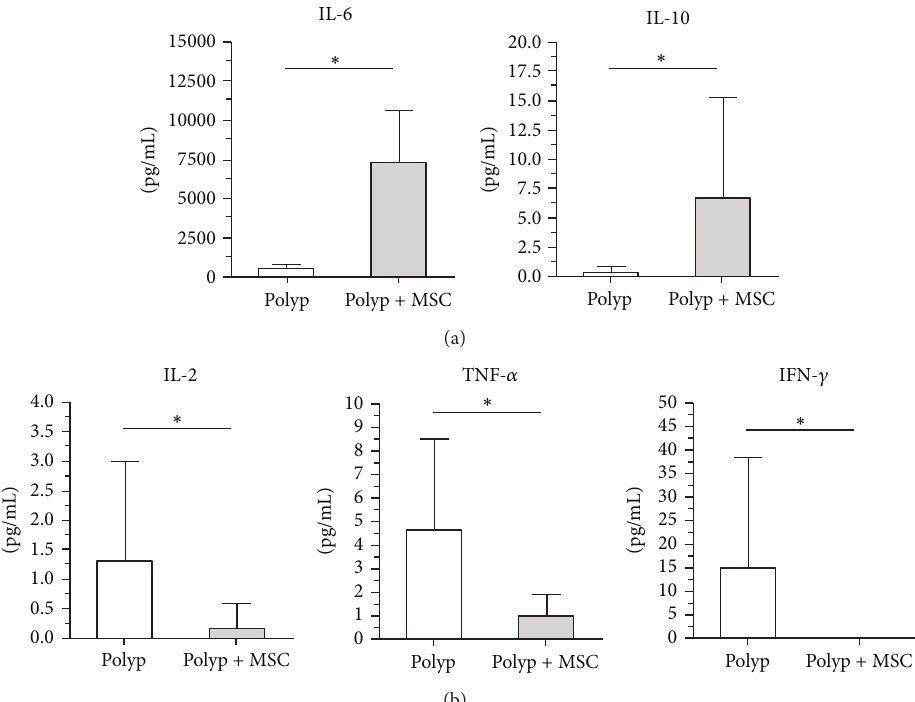
Figure 5: In vitro cytokine profile of polyp-derived cells cultured in the presence or absence of bone marrow-derived mesenchymal stem cells. A decrease in inflammatory cytokines (IL-2, TNF- 𝛼 , and IFN- 𝛾 ) and enhancement of anti-inflammatory cytokine (IL-10 and IL-6) levels was observed when MSCs were cocultured with polyp-derived